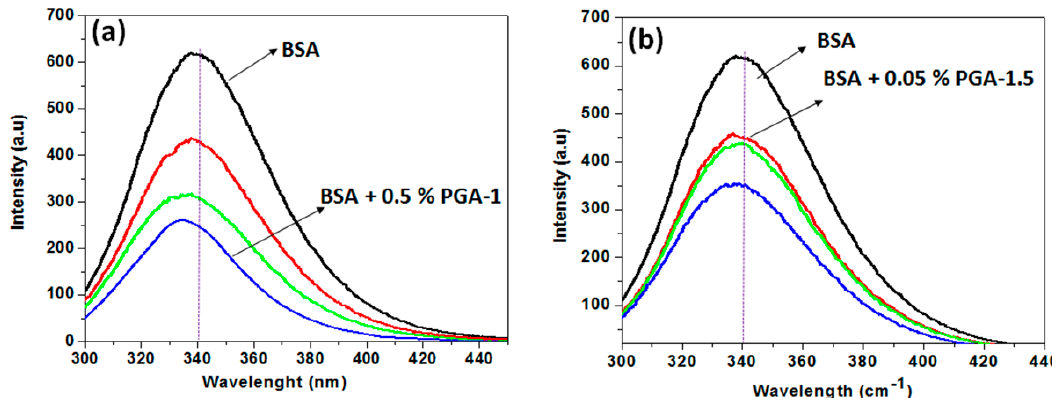
Figure 1. Fluorescence intensities of BSA in the absence and presence of PGA-1 ( a ); and PGA-1.5 ( b ) at various concentrations. The concentrations of polymers are 0.05% (red color line), 0.1% (green color line), and 0.5% (blue color line). The excitation wavelength of Trp is 295 nm.